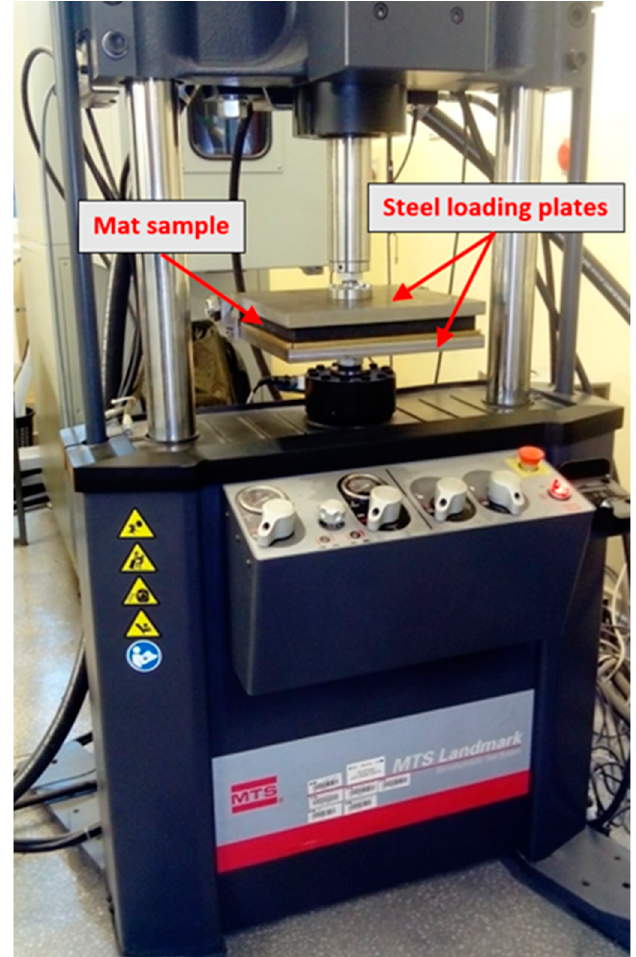
Figure 2. Laboratory stand with the mat sample.